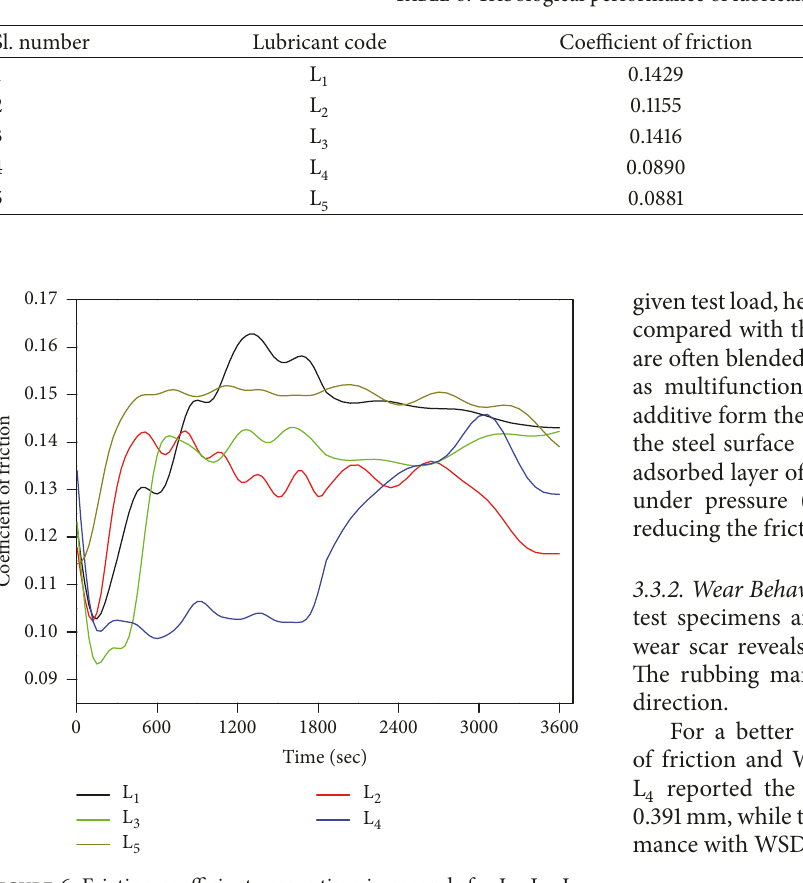
Figure 6: Friction coefficient versus time in seconds for L 1 , L 2 , L 3 , L 4 , and L 5